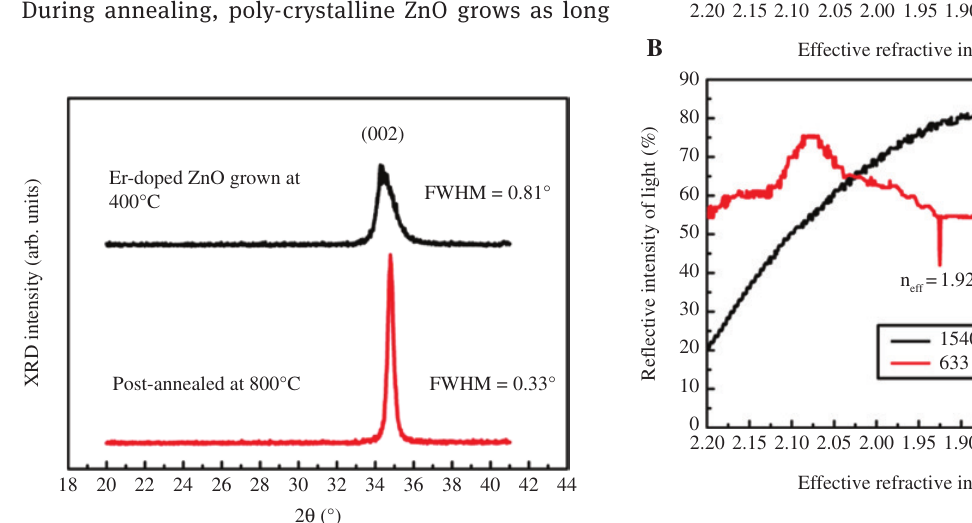
Figure 3: Relative intensity of the TE-polarized light at 633 nm and 1540 nm for (A) as-deposited film and (B) post-annealed